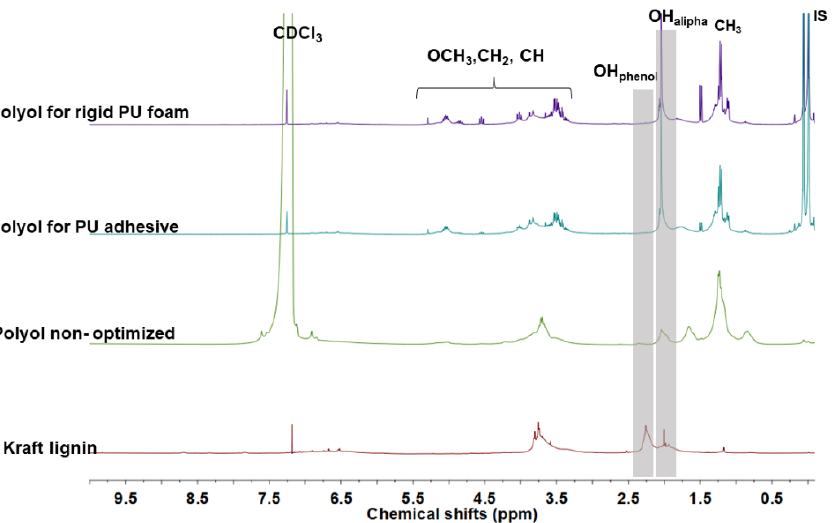
Figure 13. Quantitative proton ( 1 H) spectra NMR of acetylated kraft lignin, non-optimized polyol and crude polyols for rigid PU foam and PU adhesive.